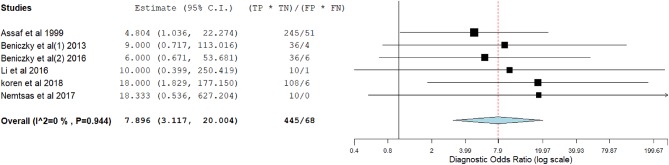
Forest plot showing diagnostic odds ratio of the IC-ESI studies (individual studies: size of the squares are proportional to weights used in meta-analysis; the summary measure: center line of the diamond; associated 95% confidence intervals: lateral tips of the squares and the diamond).